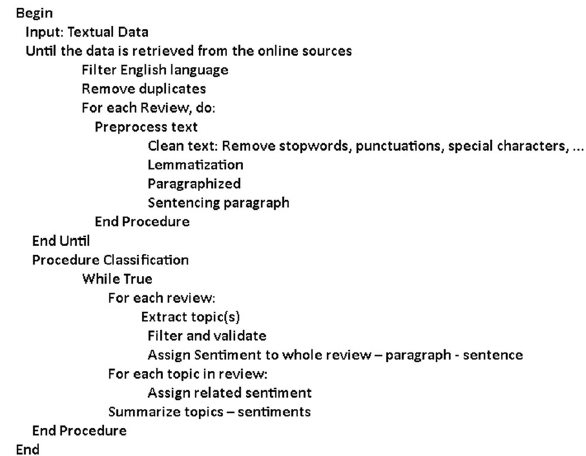
Fig. 2 A detailed algorithm for the proposed model is outlined, which aggregates topic modeling and sentiment scores at the service level to assign a sentiment score to extracted topics. Separate sentiment scores are assigned to paragraphed and sentence topics. In the end, the topic is given a weighted